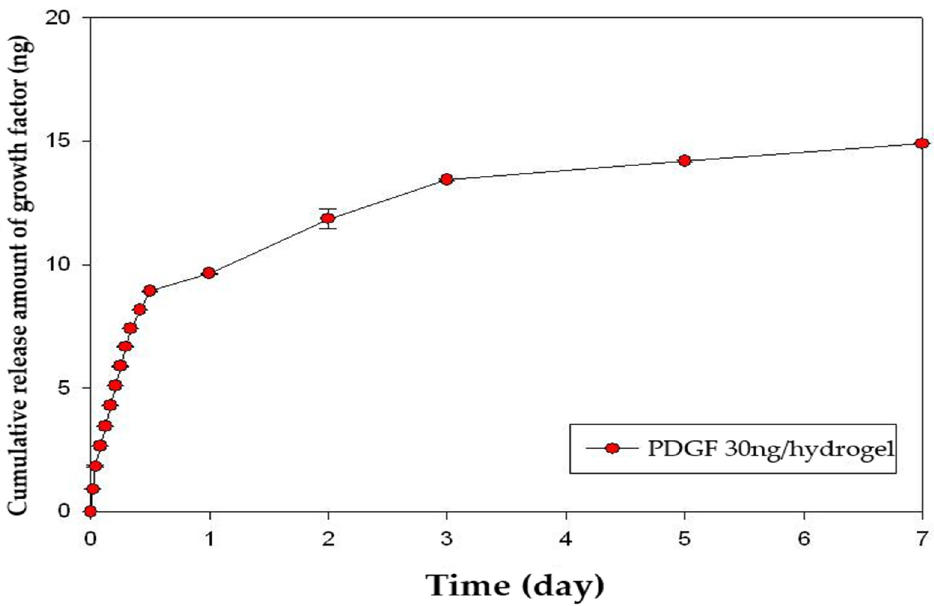
Figure 7. Cumulative release profile of PDGF-BB over 7 days. The release kinetics of growth factors was quantified by an enzyme-linked immunosorbent assay (ELISA). PDGF-BB was released sustainably for 7 days but significantly during the first 24 h. The released amount of PDGF-BB for 7 days was 50%. PDGF, platelet-derived growth factor.